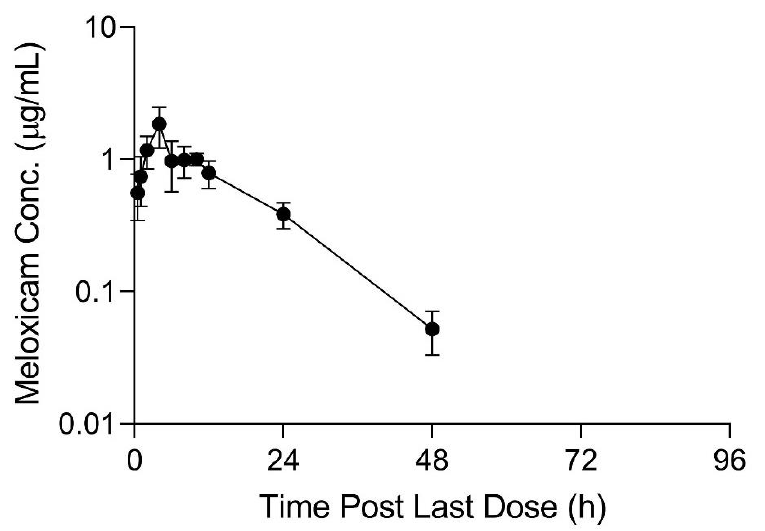
Figure 3. Mean plasma meloxicam concentrations (+SD) sampled over time (0 – 96 h) for six sheep administered 10 daily oral 1 mg/kg doses of meloxicam tablets dissolved in water. Values below the lower limit of quantitation and limit of detection are excluded.